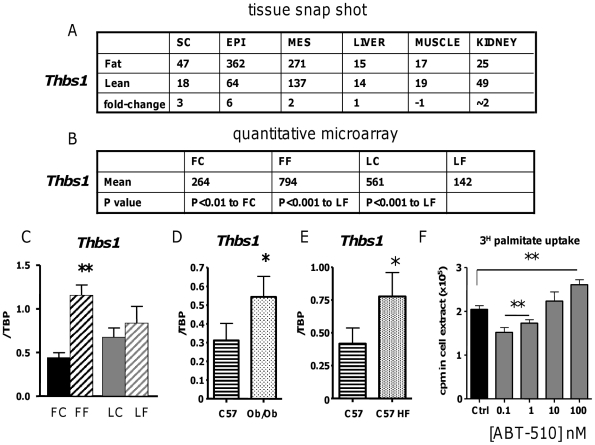
Validation and functional investigation of the candidate obesity gene Thbps1.
A. Snap-shot pooled transcriptome microarray chip intensities (arbitrary units) across subcutaneous (SC), epididymal (EPI), mesenteric (MES) adipose tissues versus liver, muscle and kidney in Fat (F) and Lean (L) mice with the rounded expression ratio in bold. B. Mean chip intensity from quantitative microarray (n = 4) in Fat and Lean mice fed control (FC, LC) or high fat diets (FF, LF) with relevant P value for significant differences. C. RT-PCR validation of changes in Thbps1 gene expression in subcutaneous adipose tissue of control diet-fed Fat (FC, black bars), high fat diet-fed Fat (FF, black hatched bars), control diet-fed Lean (LC, grey bars) and high fat diet-fed Lean (LF, grey hatched bars) mice. ** = P<0.01 versus FC. D.
Thbps1 mRNA levels in control-fed C57BL/6J (C57, horizontal striped bars) and genetically-obese leptin-deficient Lepob mice (Ob, lightly stippled bars) and E.
Thbps1 mRNA levels in control-fed C57BL/6J (C57, horizontal striped bars) and high fat diet fed C57BL/6J mice (C57 HF, heavily stippled bars). * = P<0.05 versus lean control. E. The effects of the thrombospondin-1 type 1 repeat ABT-510 (0.1–100 nM, grey bars) on 3H-palmitate uptake into fully differentiated 3T3-L1 adipocytes. ** = P<0.01 versus control (Ctrl, black bar), non-ABT510 treated cells.